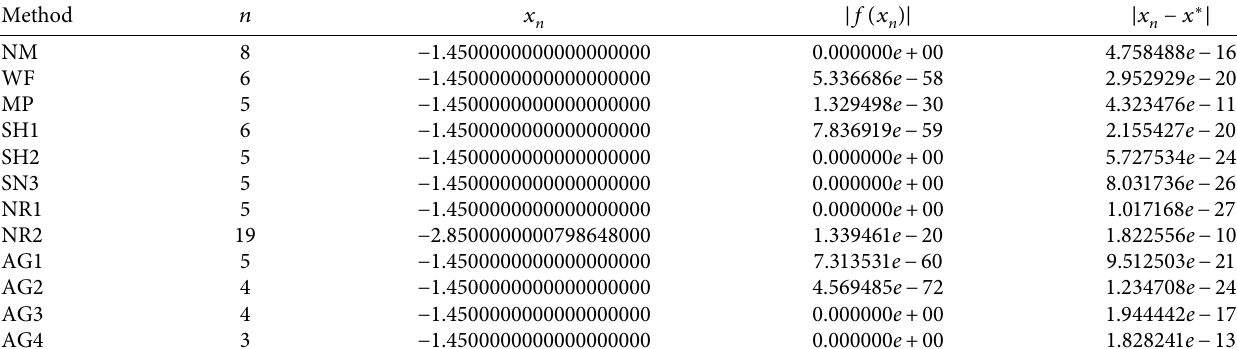
Table 3: Numerical result for continuous stirred tank reactor (CSTR).